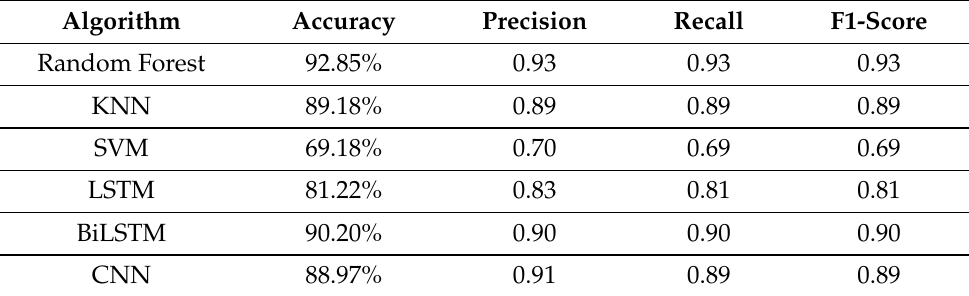
Table 4. Machine learning results using data augmentation.